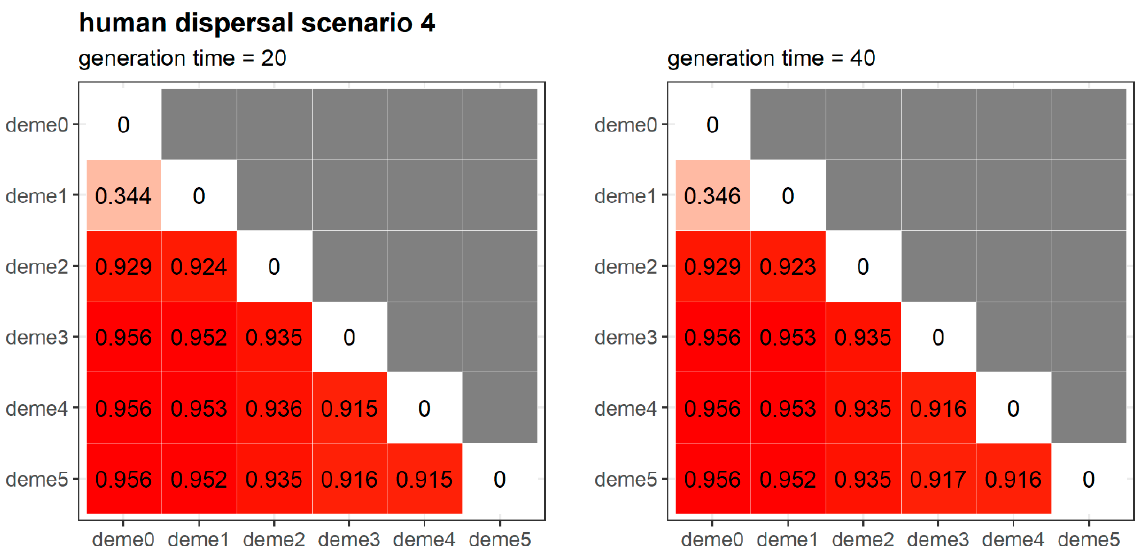
Figure A7. The mean pairwise Fst values calculated across 100 replicate simulations of a post- megafauna Indigenous-mediated dispersal scenario (“hd4” in Table A1). This scenario of Indigenous dispersal assumes that deme0 was established by propagules from deme1 5 kya, with no further migration.